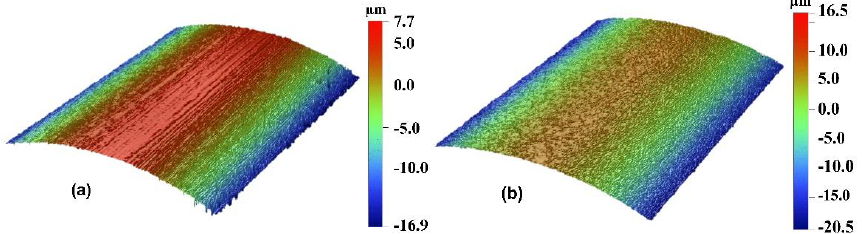
Figure 8. Typical three-dimensional surface profile of wire: ( a ) initial wire; ( b ) wire after IDD process.